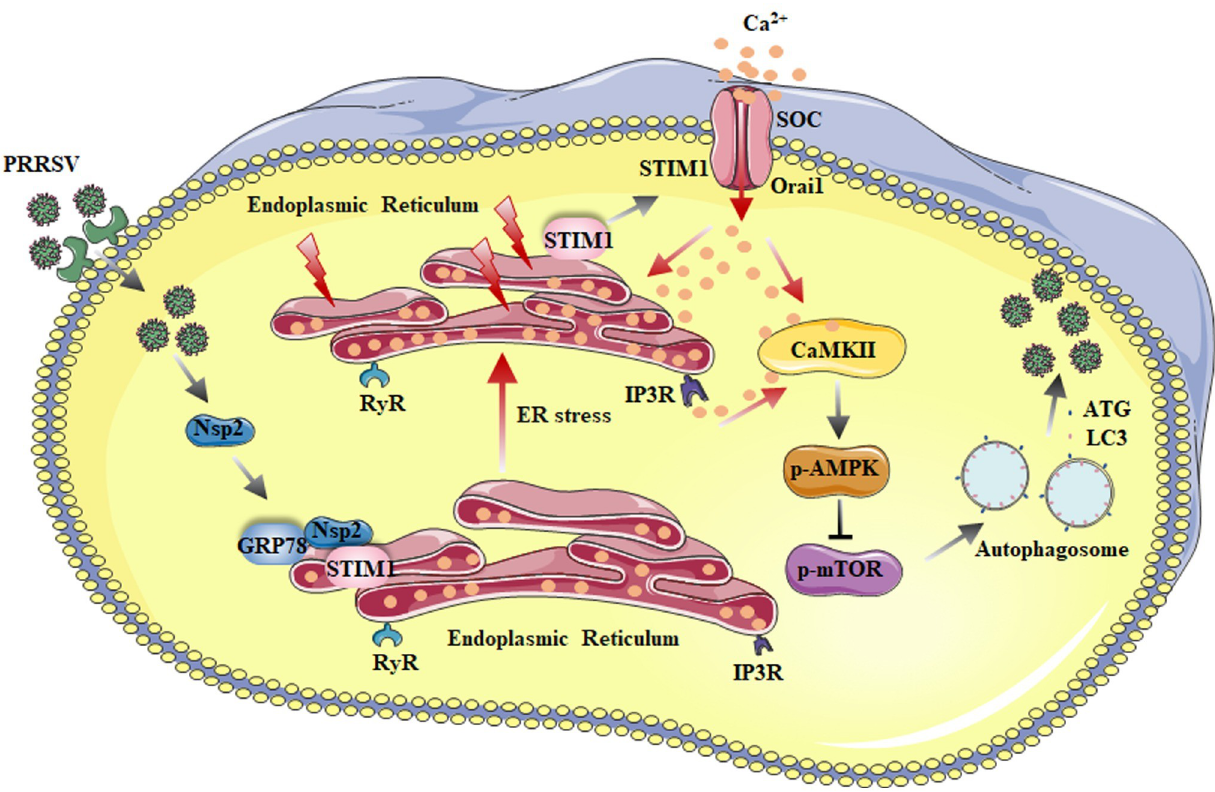
Fig 10. Model of PRRSV inducing autophagy via ER stress-induced calcium signaling pathway. PRRSV attaches to and enters cells, followed by viral protein Nsp2 interacting with GRP78 and STIM1 and inducing ER stress. ER stress results in the STIM1 moving towards to the cell membrane, opening the SOCE channel, inducing Ca 2+ influx, and finally activating the CaMKII-AMPK-mTOR-autophagy